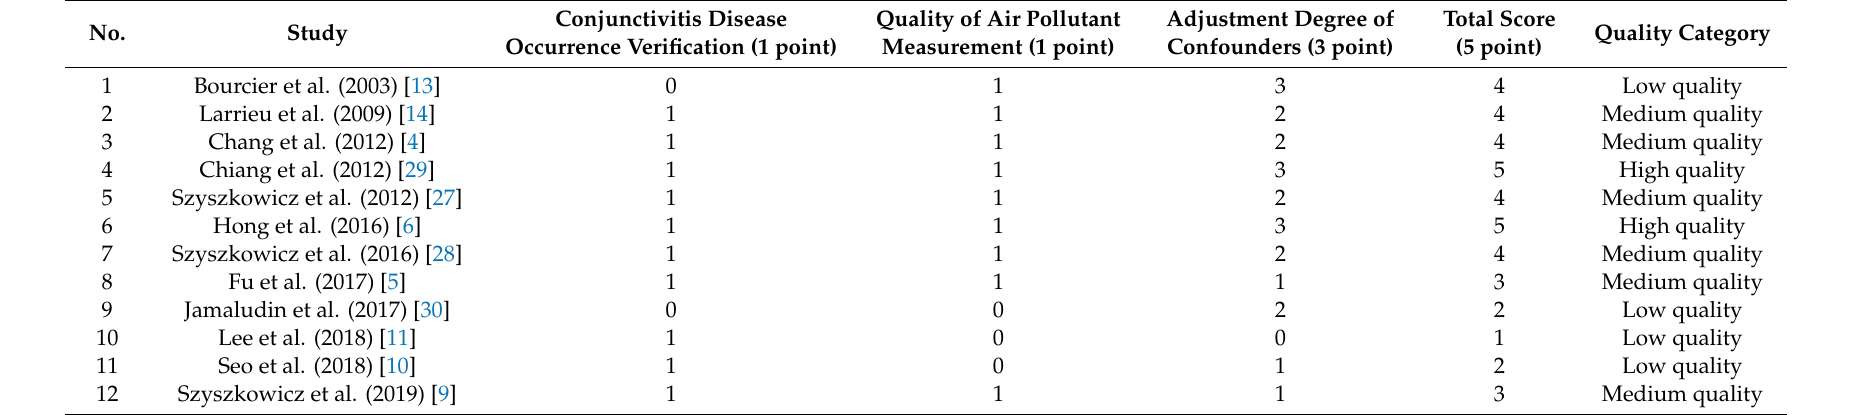
Table A3. The quality assessment of the included